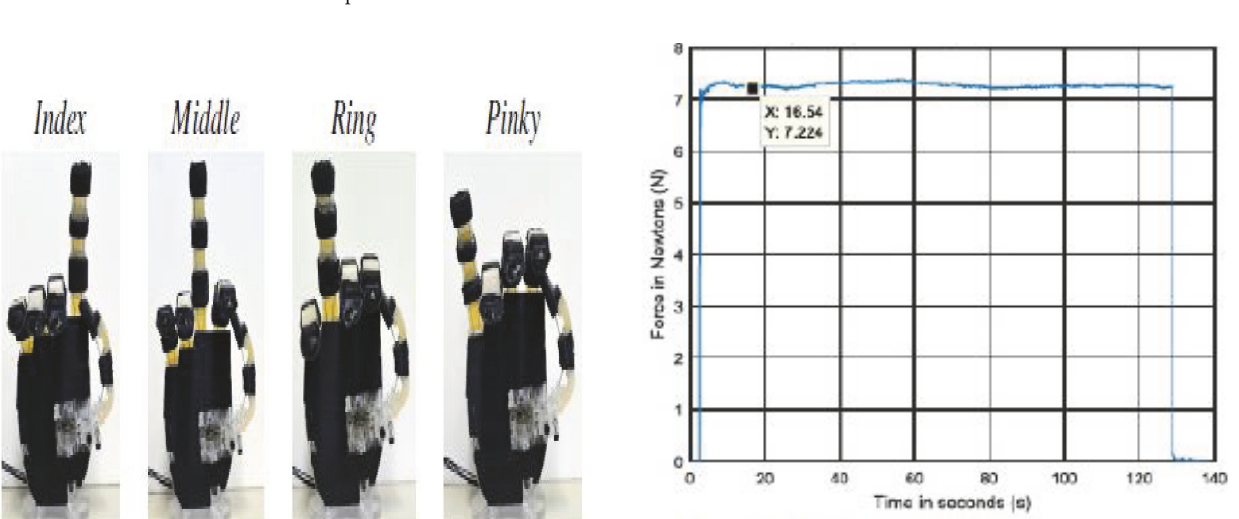
Figure 12: Thumbs displacement.